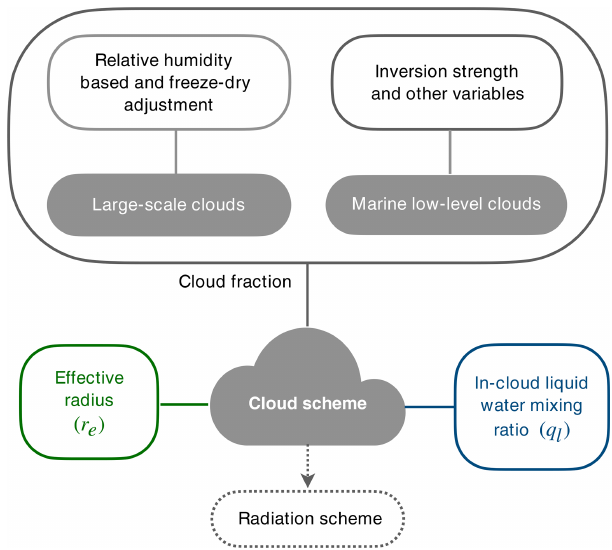
Figure 1. A sketch of the SimCloud scheme components, which includes the cloud fraction, effective radius of cloud droplet and in-cloud liquid water mixing ratio. At any given location, the max- imum of the cloud fractions from a large-scale cloud scheme and marine low stratocumulus cloud scheme is applied if both are